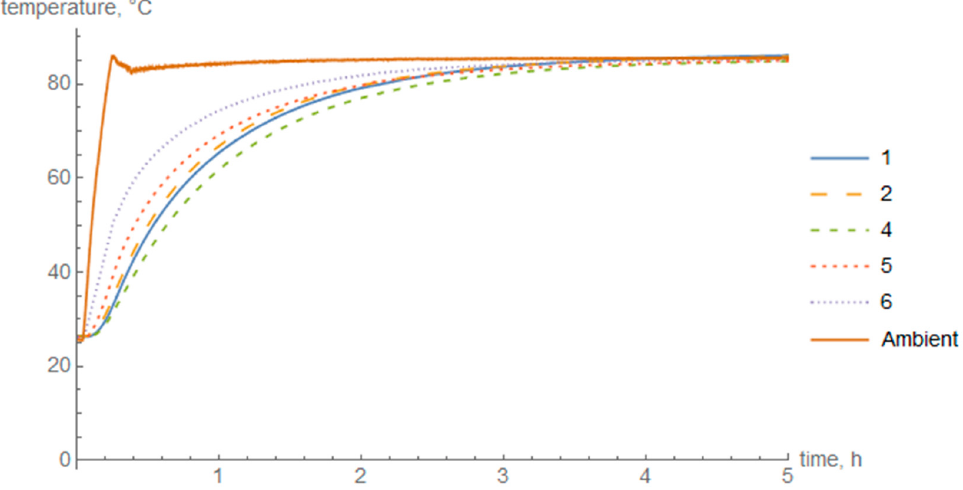
Figure 8. Temperature change in individual layers during cylinder heating.